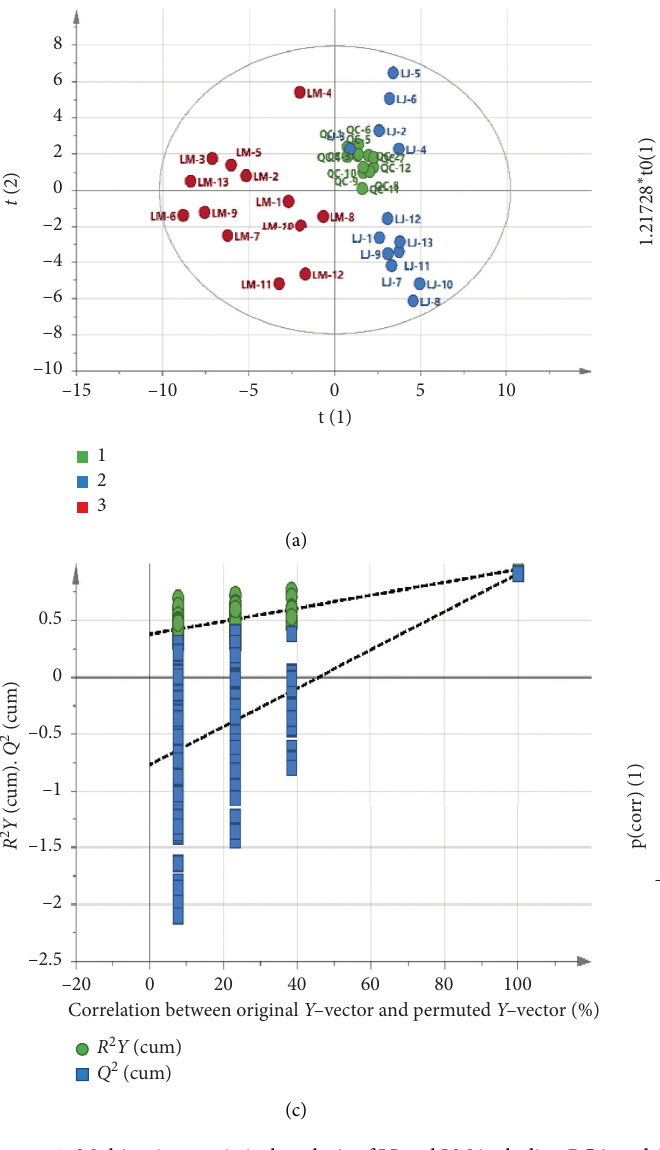
Figure 2: Multivariate statistical analysis of LJ and LM including PCA and OPLS-DA. (a) PCA score plot. (b) OPLS-DA score plot of LJ and LM. (c) The corresponding validation plots based on 200 times permutation tests of the OPLS-DA model. (d) S-plot screening of biomarkers.